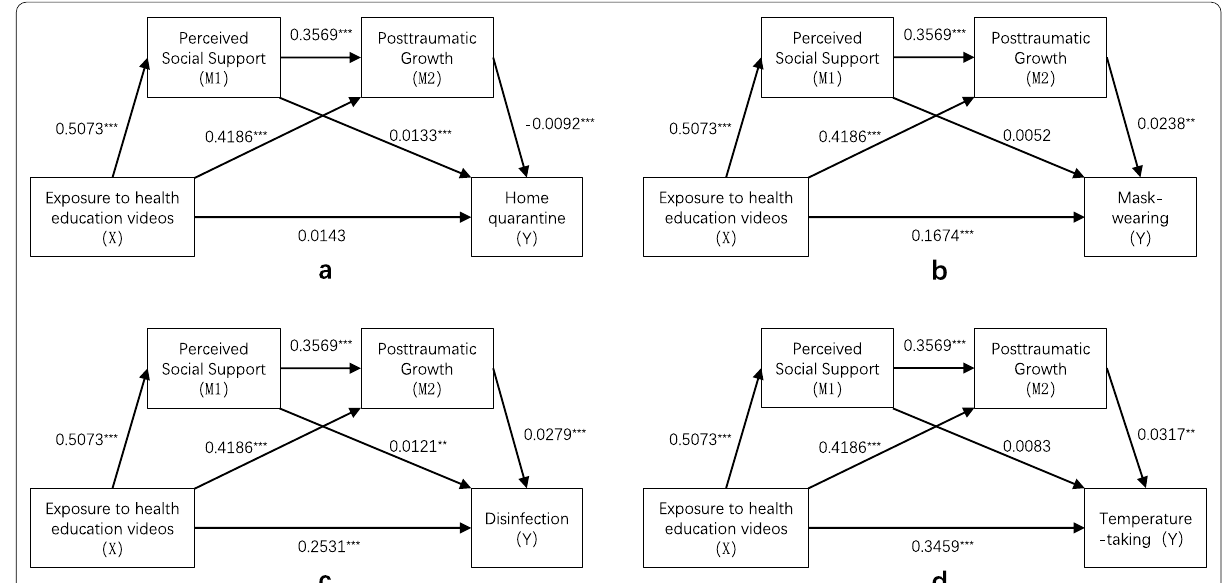
Fig. 2 Path diagram illustrating indirect effects and causal paths linking exposure to health education videos with health related behaviors. ** p < 0.01; *** p <